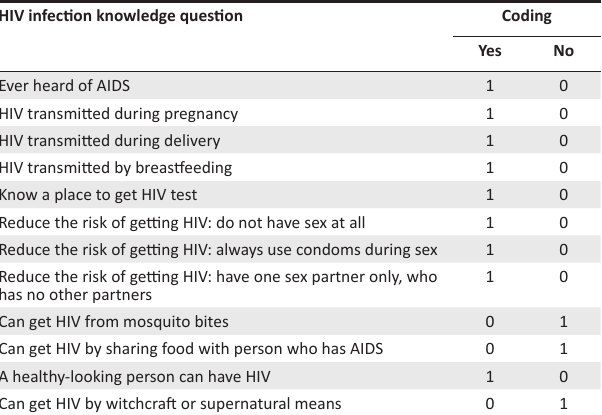
TABLE 1: Questions included in the computation of the HIV infection-related knowledge scores. HIV infection knowledge question